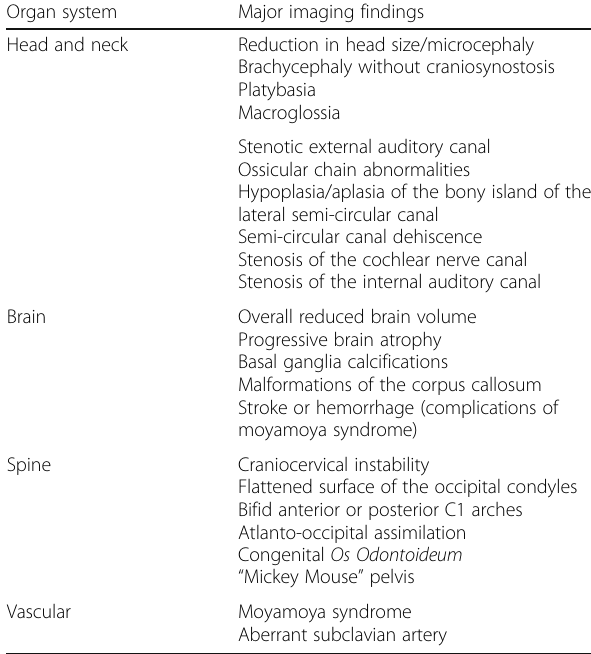
Table 1 Major neuroimaging findings in Down syndrome patients Organ system Major imaging